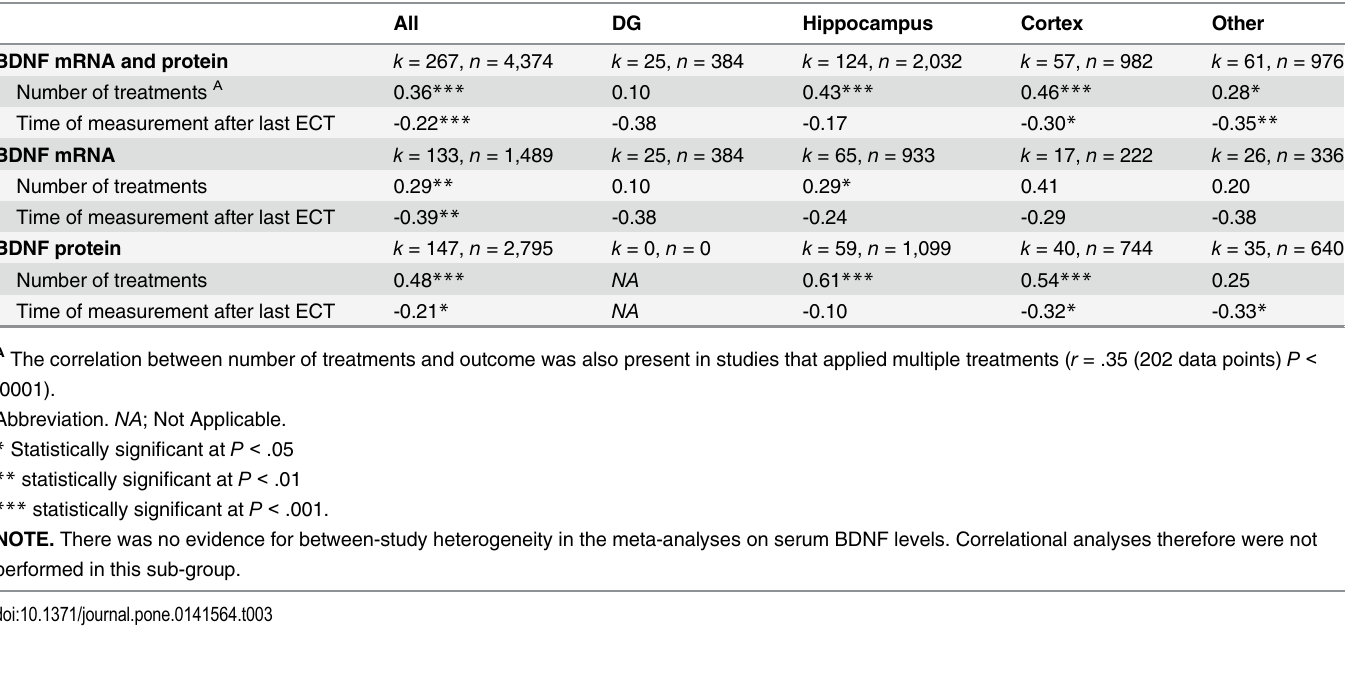
Table 3. Pearson ’ s correlation coefficients on the relation between study characteristics and study effect size (by meta-analysis indicated in the